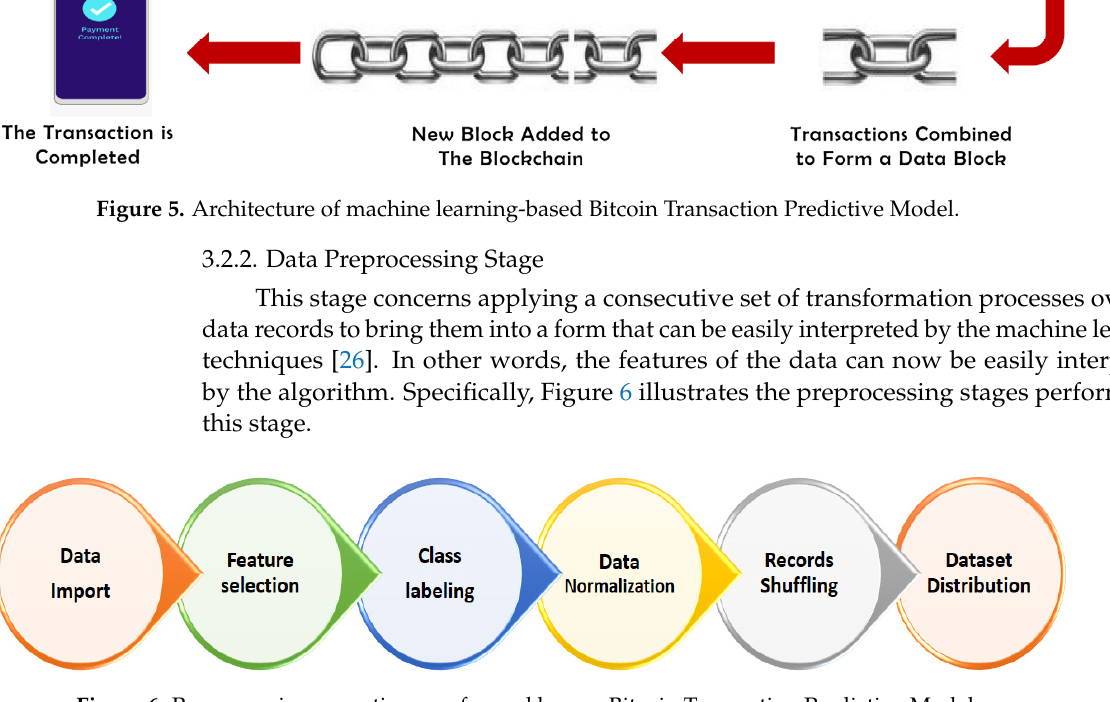
Figure 6. Preprocessing operations performed by our Bitcoin Transaction Predictive Model.